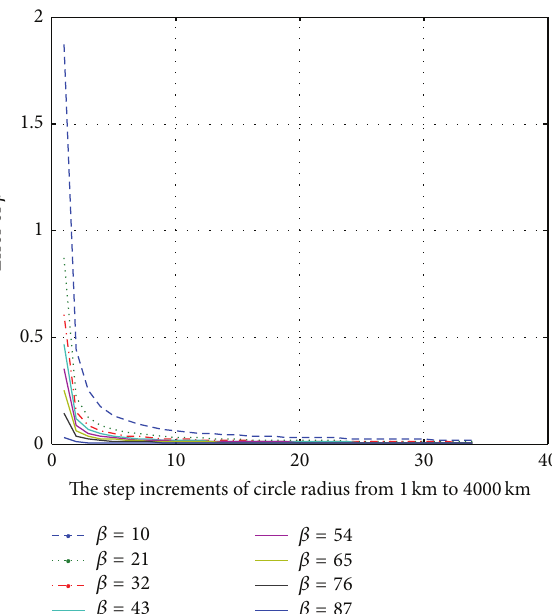
Figure 12: The maximum error of 𝛼 in a complete 360-degree rotation of the azimuth of the lightning source while the distance to antenna sensors is varied from 1km to 4000 km with 34 steps for 8 different elevation levels.